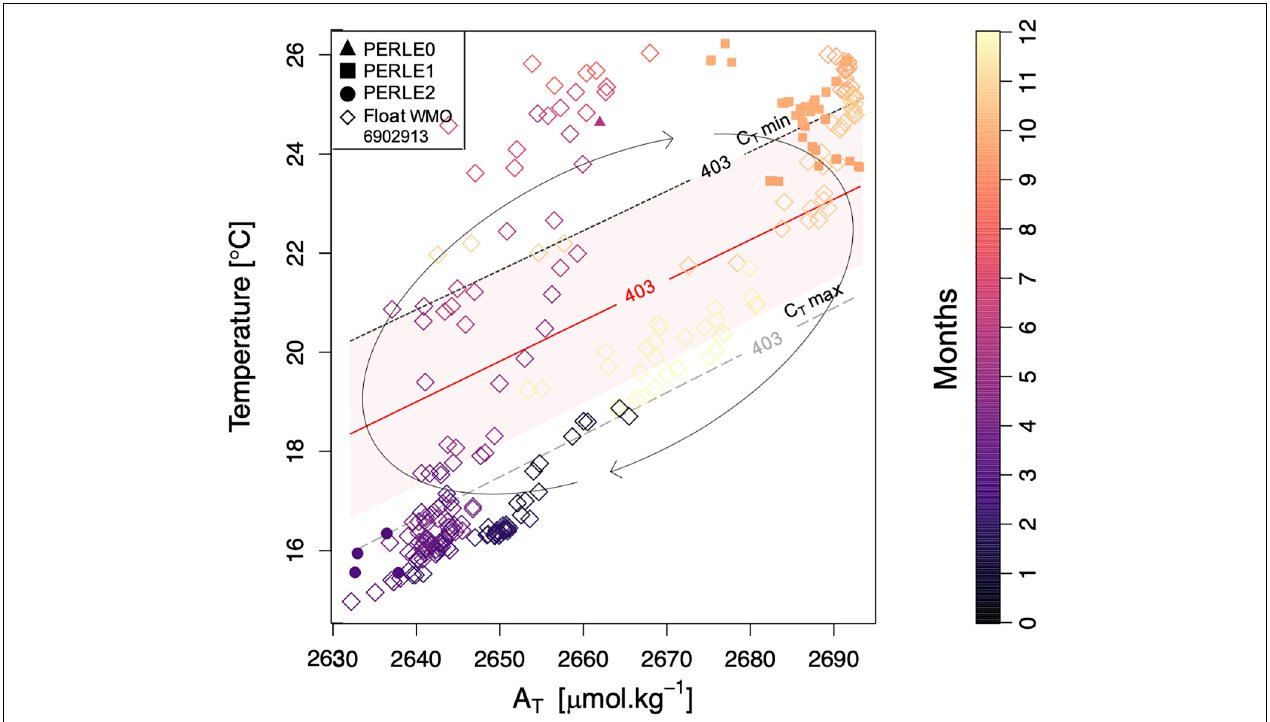
FIGURE 7 | Total alkalinity (A T ) vs. temperature in the upper 20 dbars during the three PERLE cruises and for the WMO 6902913 float data from October 2018 to July 2020 [A T values have been estimated from the float salinity following the A T -S sub-surface relationship proposed by Hassoun et al. (2015a)]. The colour bar corresponds to the “month of the year.” The red “iso p CO 2 SW -line” corresponds to the mean p CO 2 ATM value at Lampedusa site (estimated from the mean mole fraction of CO 2 in ppm) calculated with the mean C T values for all PERLE cruises ( = 403 µ atm). The two others grey isolines correspond to the same constant p CO 2 SW with the minimum and maximum C T values (from PERLE cruises) (2,292 and 2,332 µ mol.kg − 1 , respectively). Arrows reflect the theoretical changes in A T and temperature throughout the year. The coloured area represents the error associated to the red “iso p CO 2 SW -line” deduced by combining the uncertainty associated to the A T values ( i.e., ± 19 µ mol.kg − 1 ) with the default standard uncertainties from the constants (Orr et al.,